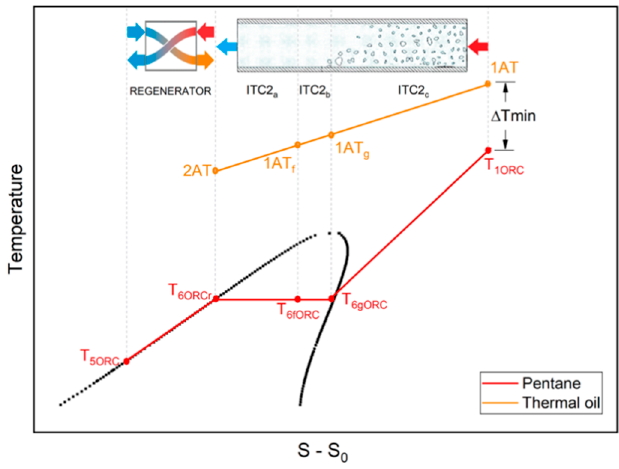
Figure 4. RORC system heat transfer diagram.